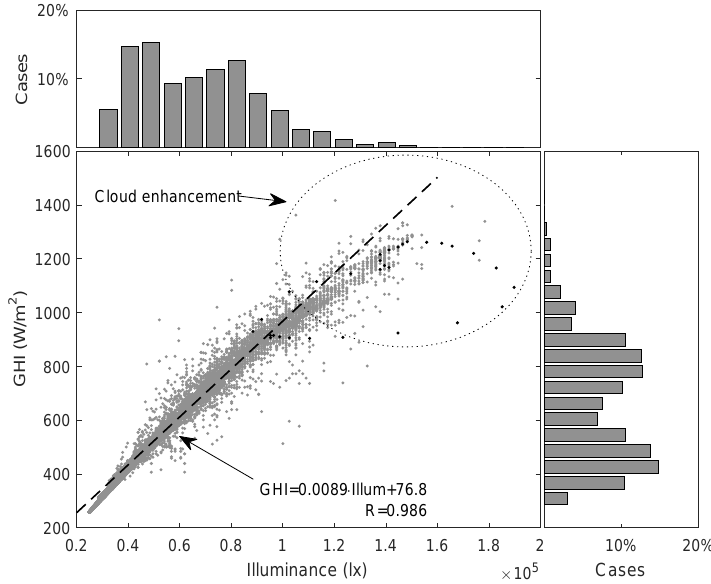
Figure 3. Scatter plot and histograms associated with the pyranometer and lux-meter #6 associated with the whole period used for